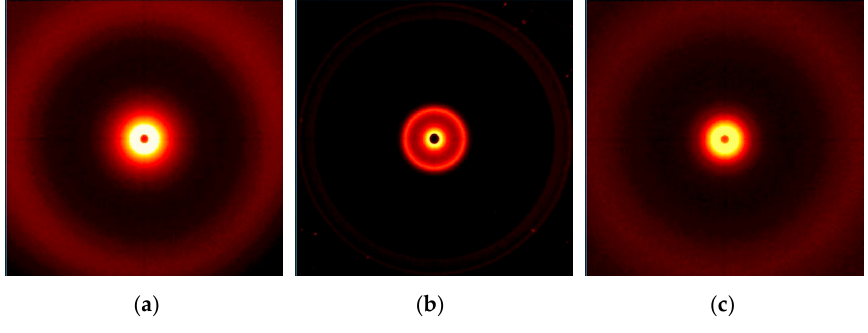
Figure 8. Results of 2D WAXS imaging of the fillers used: ( a ) S, ( b ) B, ( c ) L.